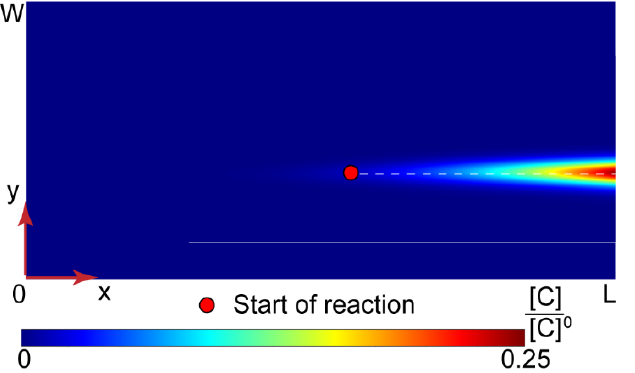
Figure 6. Numerical solution for the PAA-CTAB complexation in a Ψ -type microfluidic chip (L = 15 mm and W = 200 µ m). All the input flow rates are 10 µ L/min.